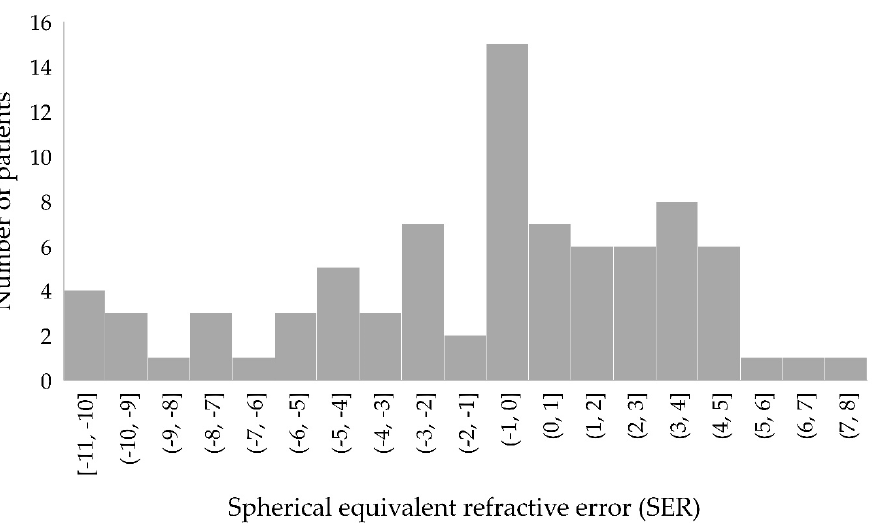
Figure 4. Distribution of the spherical equivalent refractive error (SER) of all patients. Only data for the right eye are